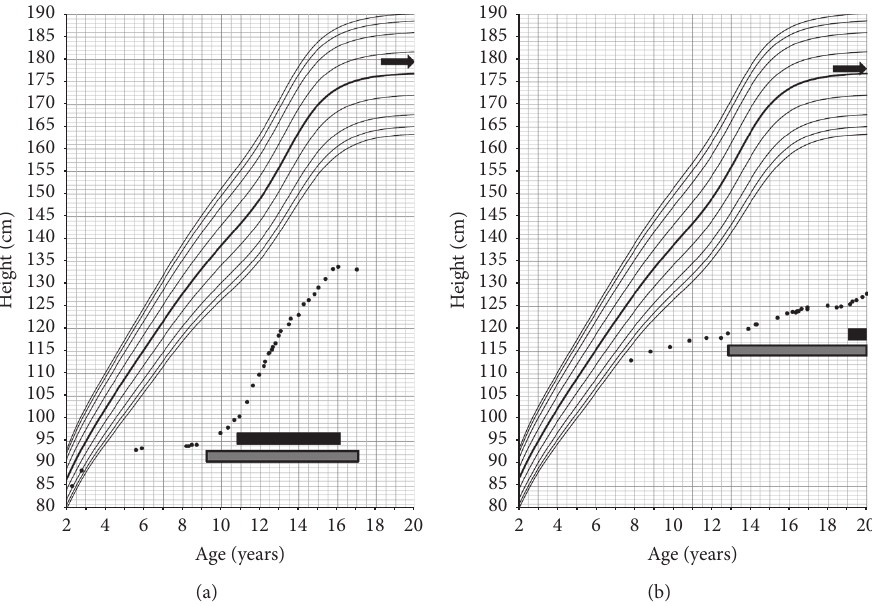
Figure 2: Growth charts of Case 1 (a) and Case 2 (b). Grey bar depicts time of initiation of Idursulfase enzyme replacement and the black bar depicts time of GH treatment. Top arrow depicts calculated midparental target height